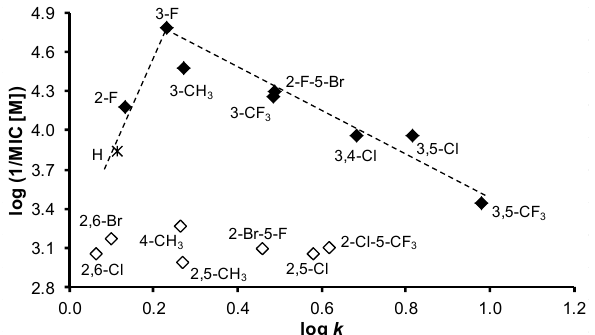
Figure 5. Relationships between in vitro antifungal activity against B. sorokiniana log (1/MIC (M)) and lipophilicity expressed as log k of studied compounds. (Derivatives excluded from SAR are illustrated by empty symbols.).